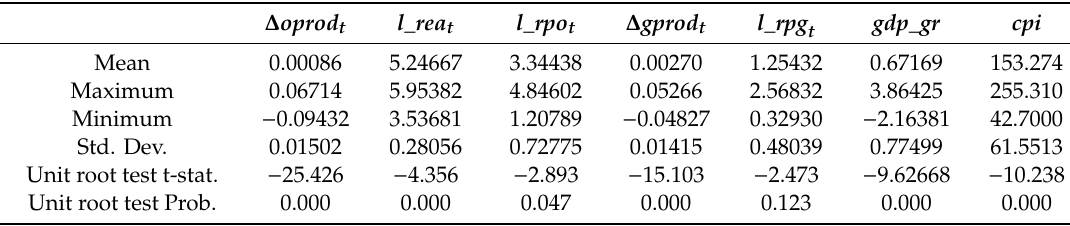
Table 2. The results of unit root tests for the